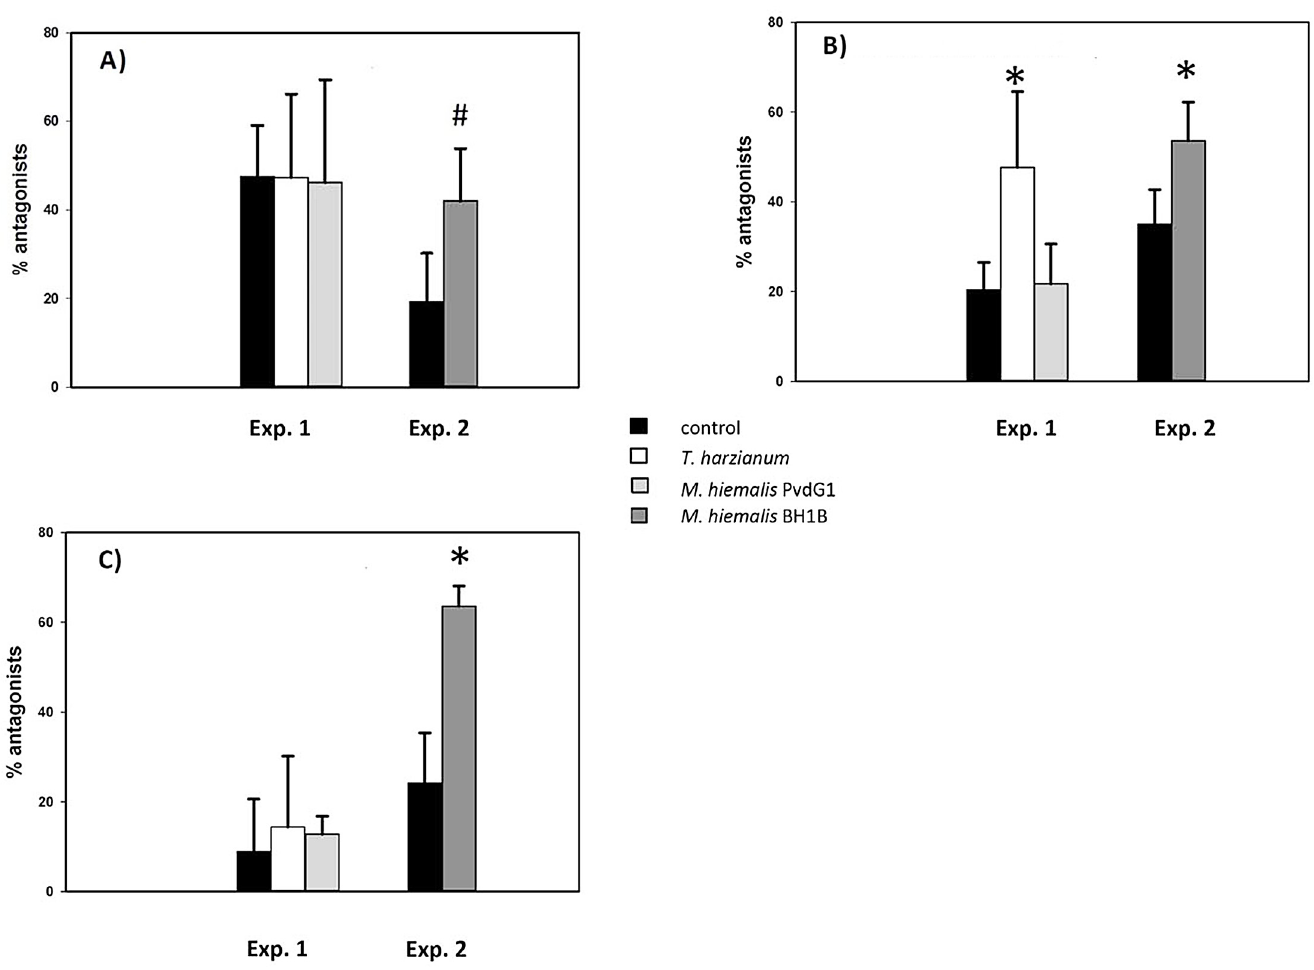
Fig 4. Percentage of rhizosphere bacteria isolates with in vitro antagonistic activity against different fungi. Bacterial isolates were obtained from root- adhering soil after 6 weeks of growth of Carex arenaria seedlings in quartz sand microcosms. * indicates significant difference (p < 0.05) between microcosms with and without pre-inoculation of fungi, for the ANOVA test of data of the white column in Fig 3B Log transformation was applied; # indicates p = 0.072. Note that experiment 1 and 2 started with different bacterial inoculums a as indicated in Material & Methods. Data are the averages of three randomly selected sand microcosms. Error bars represent standard deviation. For each microcosm 40 bacterial isolates were individually screened for in vitro antagonisms against the different